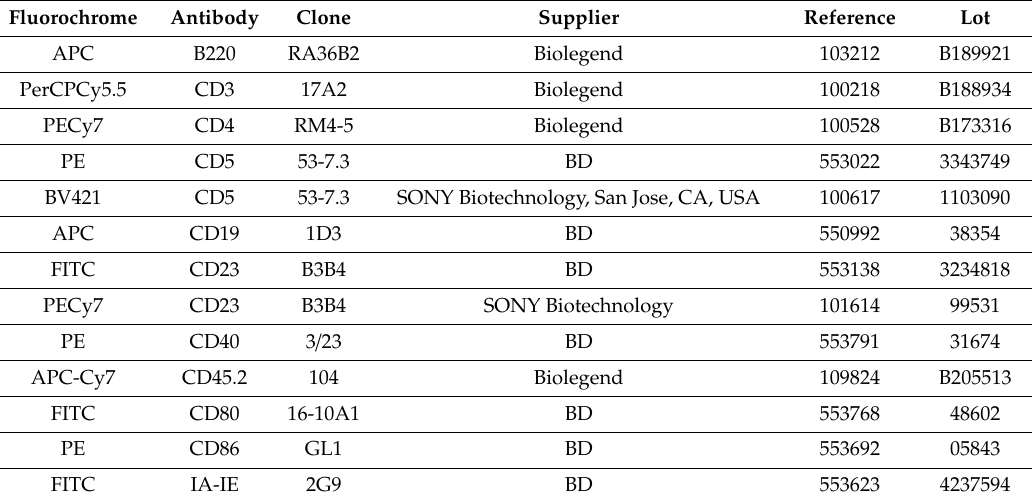
Table 2. List of